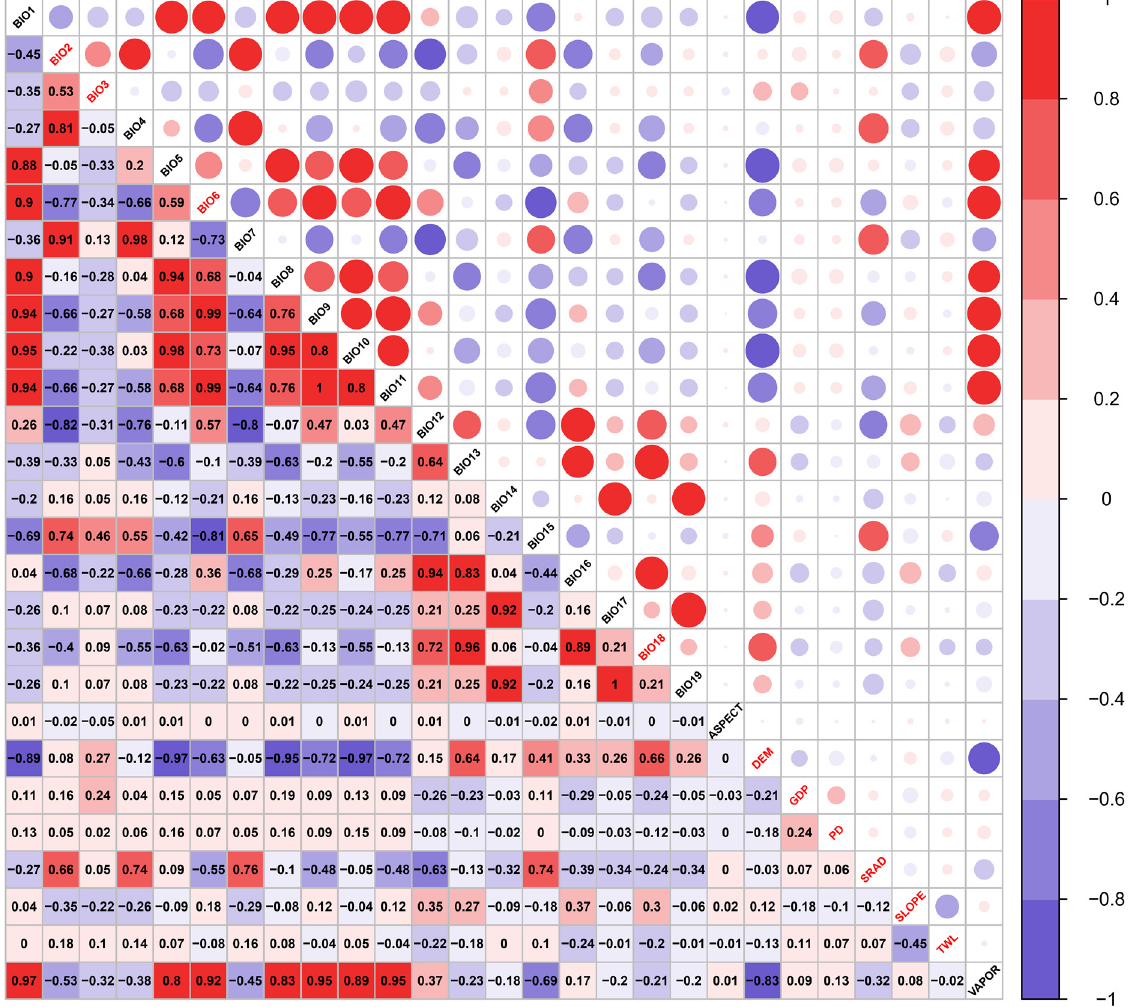
Figure 2. Correlations among 27 variables in Table 2. The red color stands for positive correlations and the blue color stands for negative correlations. The stronger the correlation between variables, the darker the color and the higher the saturation and the larger the size of the circle, the greater the correlation between variables. The red fonts represent the selected variables.